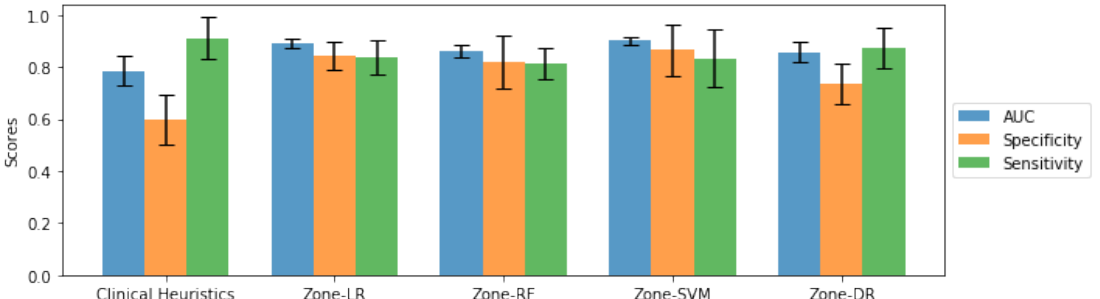
Figure 5. Performance bar plot (with error bars) of zone-level, pathologically-verified prostate cancer grading results for the tested zone-level prostate cancer sensing strategies using ADC, averaged over 5 folds, along with their corresponding standard